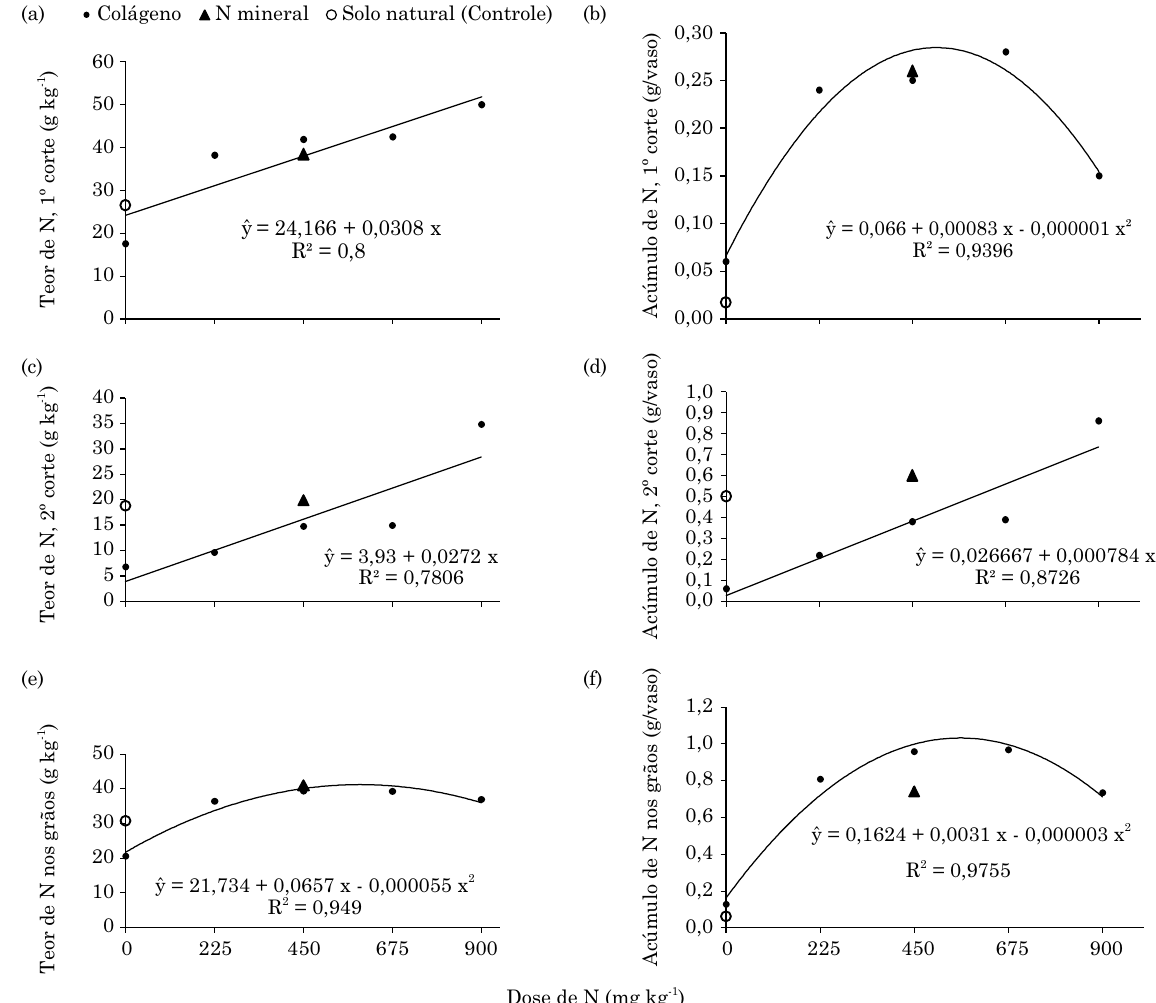
Figura 2. teor e acúmulo de nitrogênio na parte aérea de plantas de trigo no 1º corte (a, b) e no 2º corte (c, d) e nos grãos (e, f) submetidas a doses de nitrogênio via colágeno de curtume e dois tratamentos adicionais, cultivadas em Latossolo Vermelho Distrófico